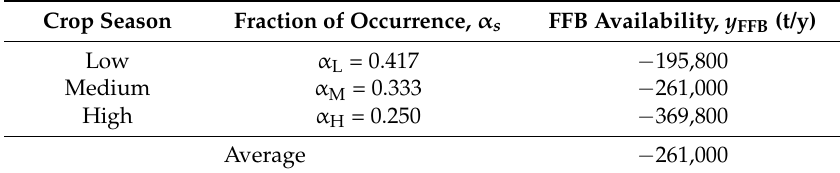
Table 1. The fraction of occurrence and FFB availability for different crop